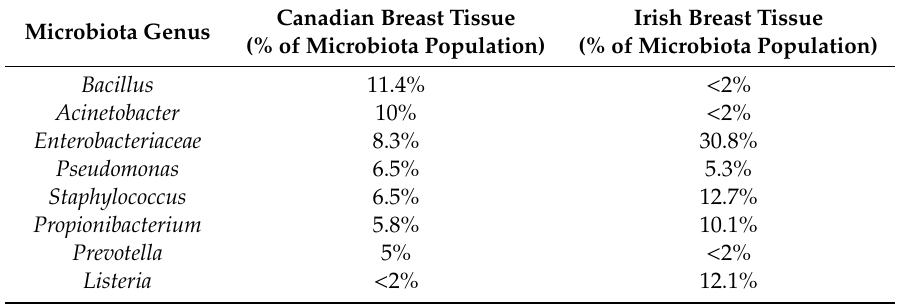
Table 1. Microbiota genus proportional abundance found in human mammary gland samples (adapted from Urbaniak et al. 2014